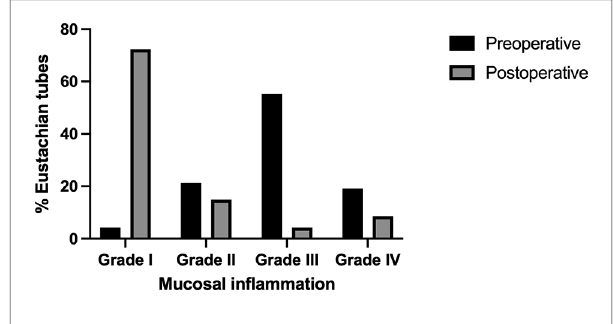
FIGURE 2 Eustachian tube mucosal in fl ammation scale preoperatively and at a 3-month